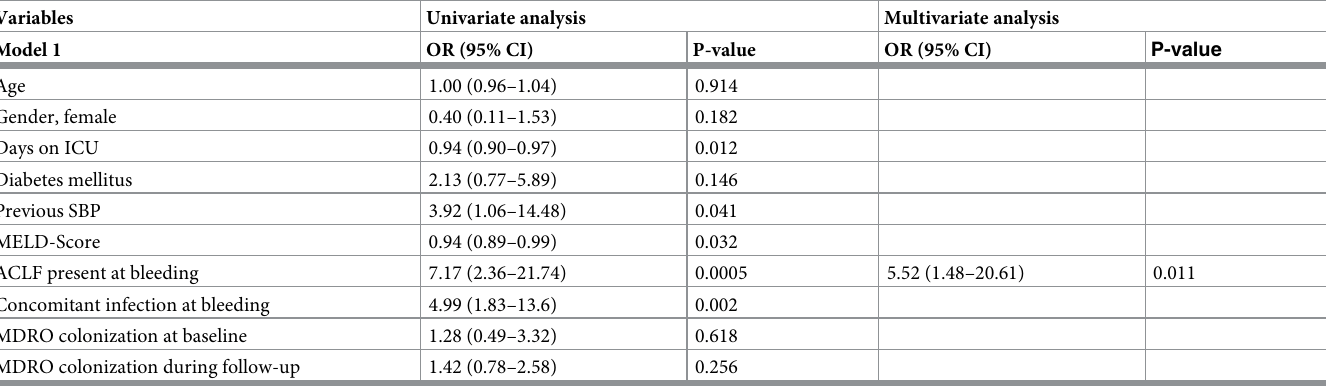
Table 2. Uni- and multivariate logistic regression analysis investigating risk factors for de-novo infection within 10 days under antibiotic prophylaxis. Variables Univariate analysis Multivariate